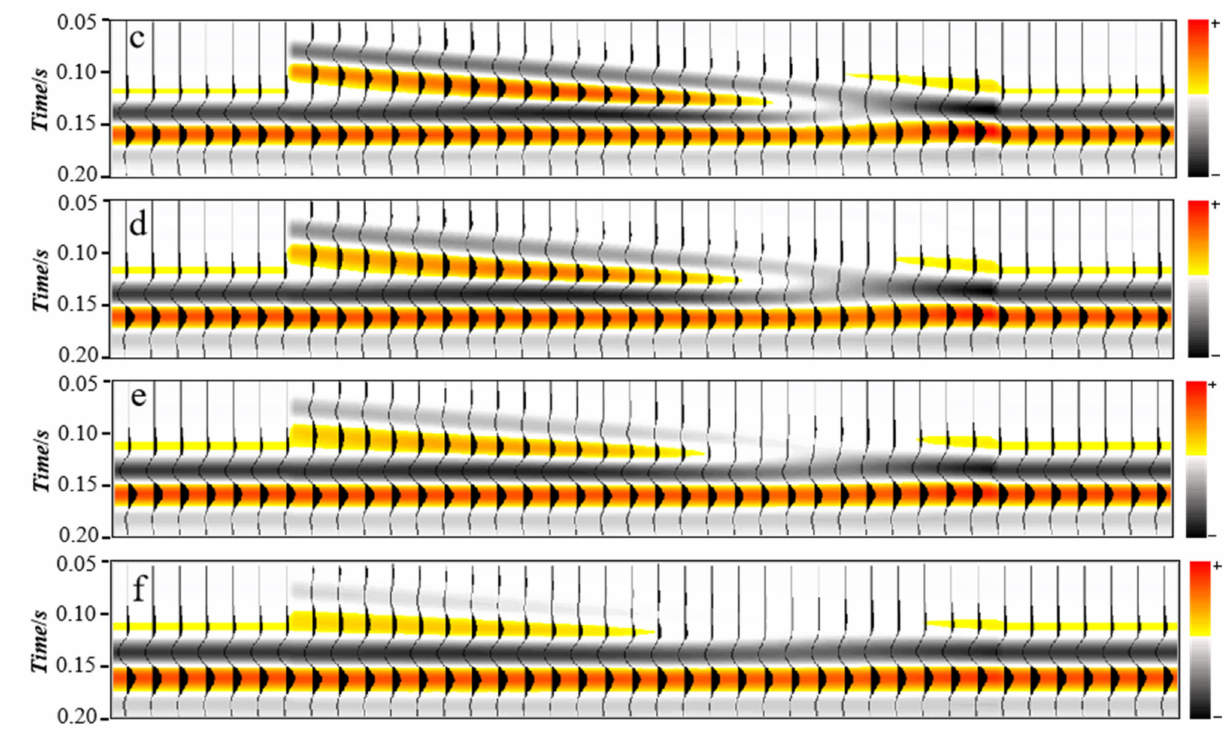
Figure 7. Seismic response of the partial stacked seismic analysis for sandstone–coal assemblage at different stack angles: ( a ) geologic model; ( b ) partial stacked seismic analysis 0–7 ◦ ; ( c ) partial stacked seismic analysis 7–14 ◦ ; ( d ) partial stacked seismic analysis 14–21 ◦ ; ( e ) partial stacked seismic analysis 21–28 ◦ ; ( f ) partial stacked seismic analysis 28–35 ◦ .